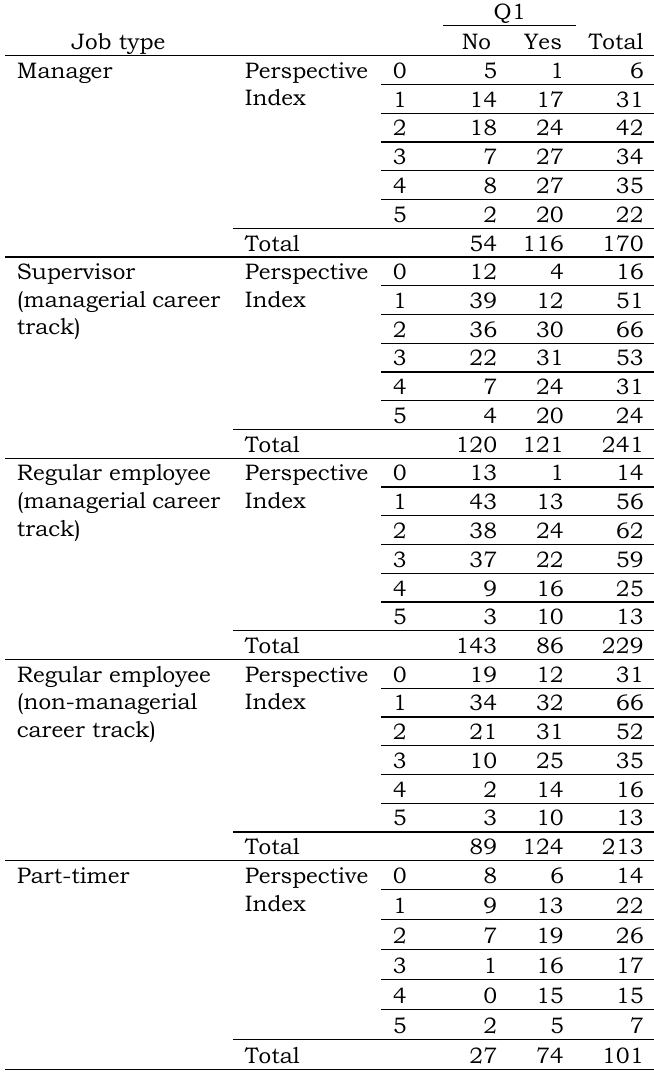
Table 4. Crosstab of job type, perspective index, and job